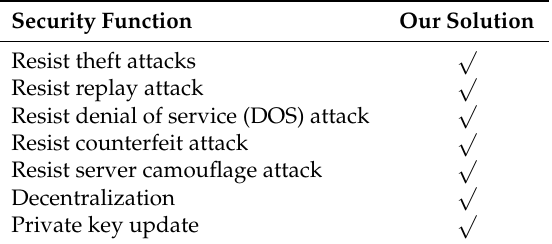
Table 2. Analysis of safety